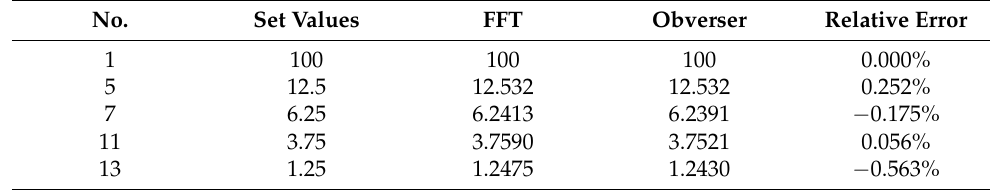
Table 3. Comparison between the FFT method and the harmonic observation system.